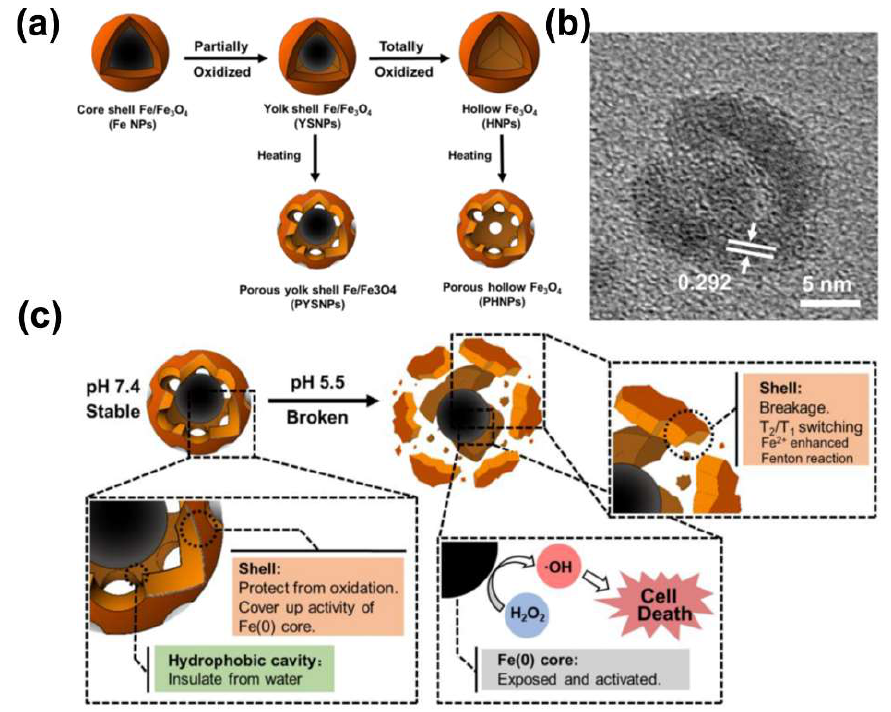
Figure 3. ( a ) Schematic illustration of PYSNP preparation in [64]. ( b ) HRTEM images of PYSNP. ( c ) Schematic illustration of the pH activated Fe release in PYSNPs. Reprint with permission from [81]. Copyright 2020 Elsevier Ltd., Amsterdam, The Netherlands.